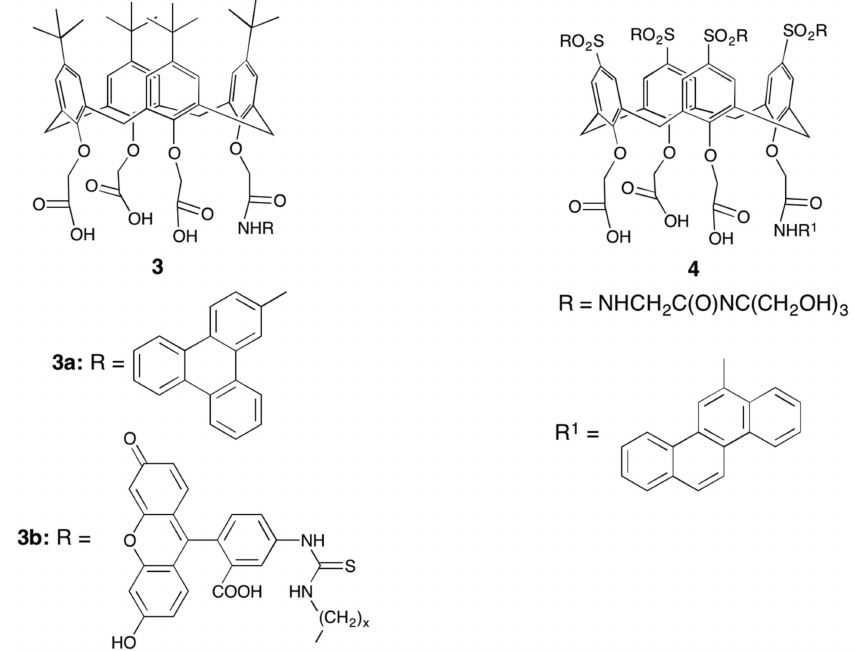
Figure 5. Tetrasubstituted calix[4]arene derivatives that form neutral lanthanoid light emitting